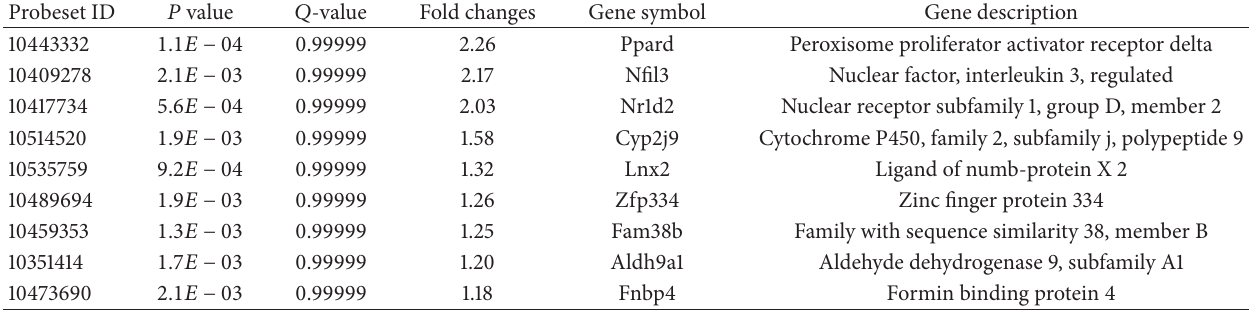
Table 3: List of genes whose expression in mouse liver by chronic VPA treatment is dependent on Wfs1 genotype as measured by Affymetrix GeneChip Mouse Gene 1.0 ST Array.